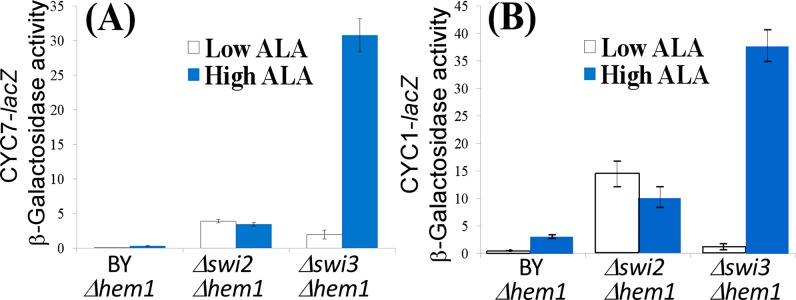
Swi2 and Swi3 exert differential effects on respiration gene transcriptionDeletion of the SWI3 gene, not SWI2, causes a significant increase in the CYC7 (A) and CYC1 (B) promoter reporter activities in haem-sufficient cells. Yeast parent BY4741Δhem1 (BYΔhem1), BY4741Δswi2Δhem1 (Δswi2Δhem1) and BY4741Δswi3Δhem1 (Δswi3Δhem1) strains bearing the CYC1-lacZ or CYC7-lacZ reporter plasmid were grown in the presence of 2.5 μg/ml (low ALA) or 250 μg/ml (high ALA) haem precursor ALA. β-Galactosidase activities were measured and plotted here. Data shown here are averages from at least three independent measurements.